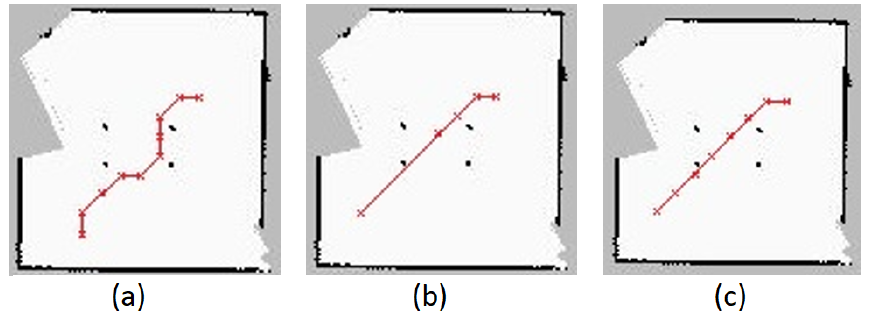
Figure 21. Planned pathways with forward transmission ( a ), with forward and backward transmis- sion ( b ), and with the A* algorithm ( c